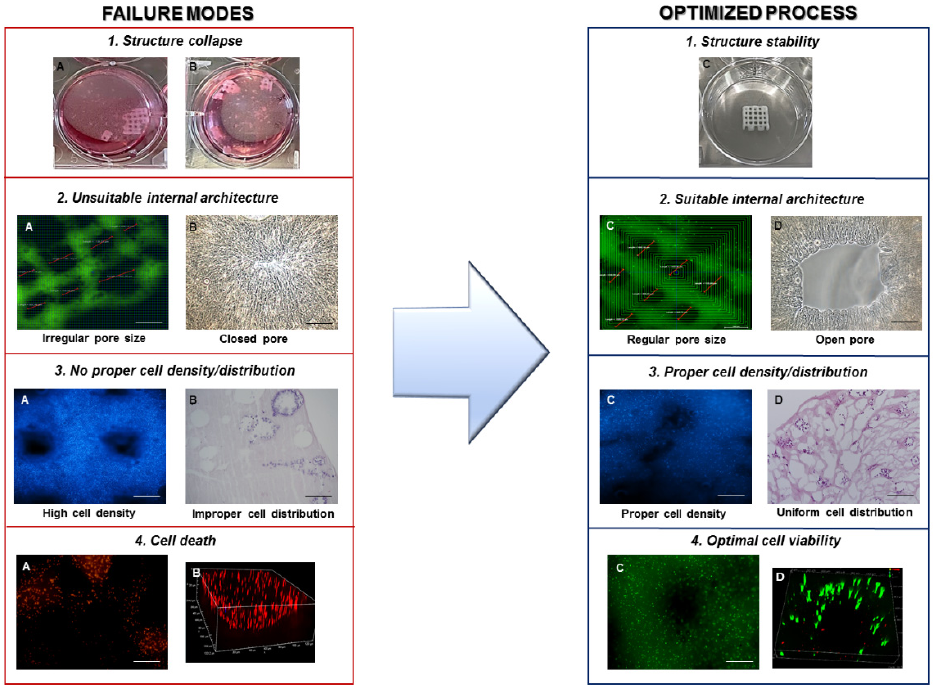
Figure 3. Schematic representation of possible failure modes with their related consequences (left part) and improved outcomes after mitigation actions (right part). (1) Macroscopic images of a scaffold losing shape stability under culture conditions ( A , B ; left panel) and scaffold with a stable structure ( C , right panel). (2) Fluorescence ( A ) and bright-field microscopy ( B ) images of a scaffold presenting irregular/closed pore size (left panel) and suitable pore distribution and shape ( C , D , right panel). (3) Fluorescence microscopy image with DAPI staining ( A ) and histological staining with Hematoxylin/Eosin ( B ) showing an unsuitable (left panel) and suitable cell density and distribution (right panel). (4) Fluorescence microscope image of Live and Dead assay reporting dead cells (red staining) in 2 dimensions ( A ) and after three-dimensional stack ( B ) (left panel) and live cells (green staining) in 2D ( C ) and after 3D stack ( D ) (right panel).